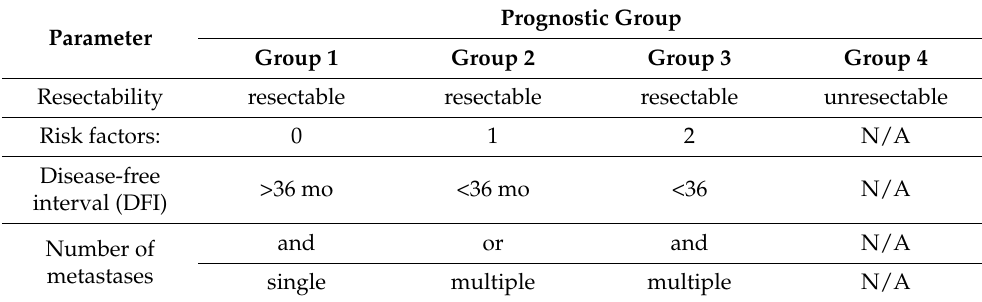
Table 3. International Registry of Lung Metastases